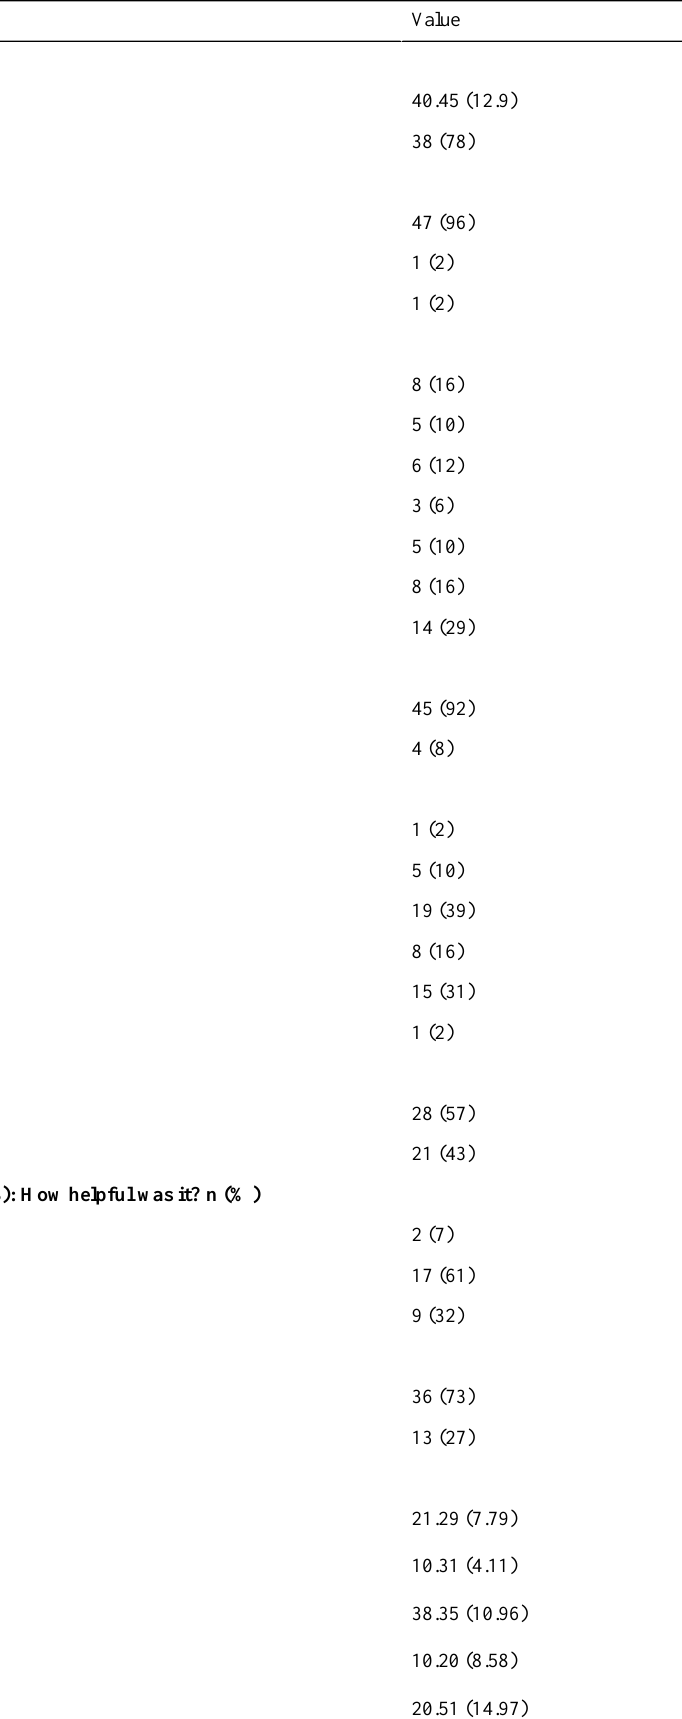
Table 2. Baseline characteristics